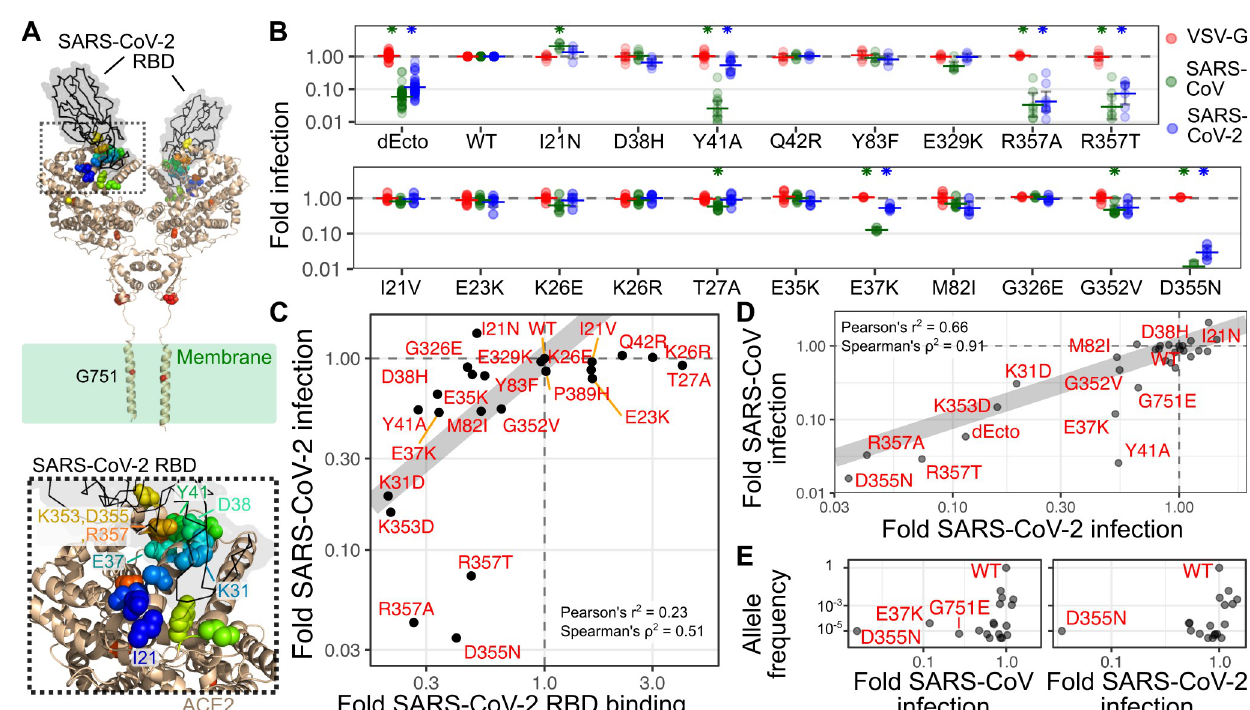
Fig 4. ACE2 variant effects on binding and infection. A) Structure of the SARS-CoV-2 RBD in complex with ACE2, from PDB 6M17. Positions of variants tested in the manuscript are shown as spheres colored according to their order from the N- to C-terminus. (Bottom) A zoomed in view of the RBD:ACE2 interface, where the majority of the tested variants are found. B) Infection of a panel of ACE2 variants of residues near the spike interaction surface, separated into variants currently unobserved (top) and observed (bottom) in publicly available human genomics datasets. n = 5 or more replicates, error bars denote 95% confidence intervals. C) Scatter plot showing relative pseudovirus infection rates (y-axis) and the mean value of the published SARS-CoV-2 RBD-sfGFP staining (x-axis) for WT ACE2 and its variants. D) Scatter plot showing normalized infection of SARS-CoV-2 (x-axis) or SARS-CoV (y-axis) spike pseudoviruses. E) Scatter plot comparing the pseudovirus infection values of SARS-CoV or SARS-CoV-2 pseudoviruses with their average allele frequencies observed in the GnomAD and BRAVO exome databases. The grey line in panels C and D, denote a hypothetical perfect correspondence between assays with a slope of